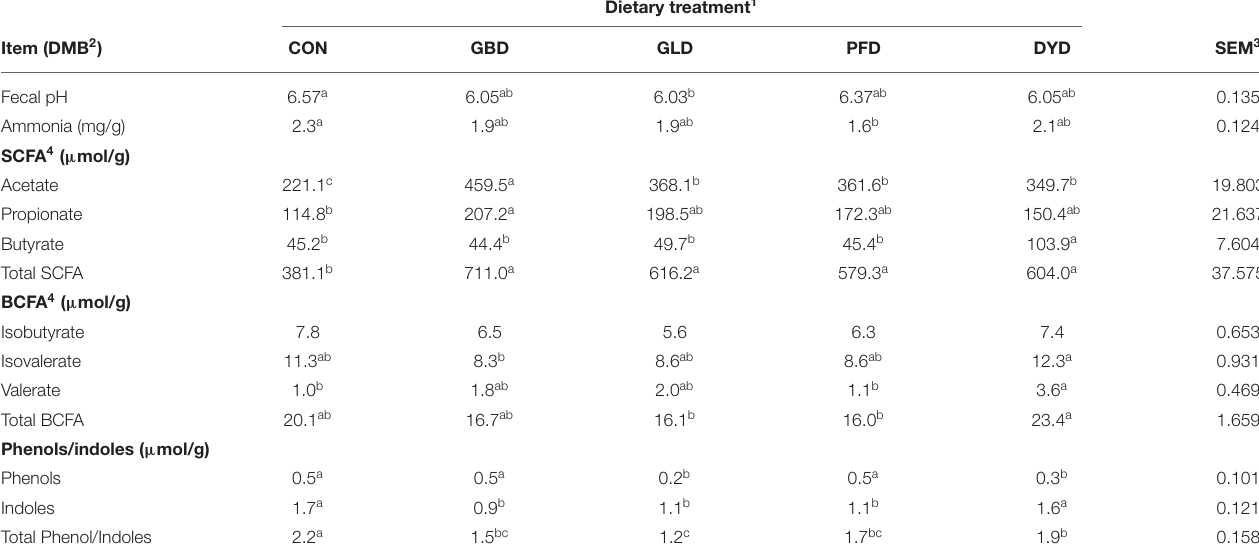
Dietary treatment 1